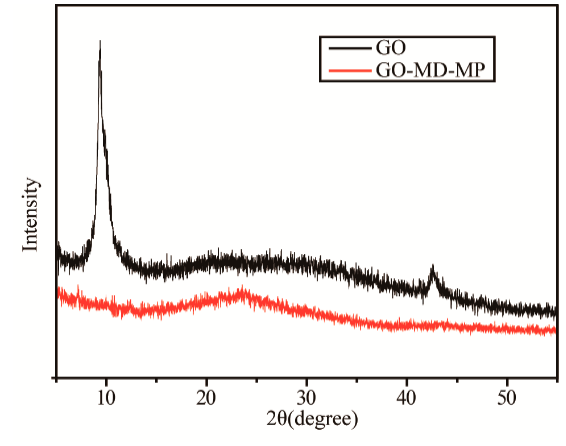
Figure 6. XRD patterns of GO and GO-MD-MP.